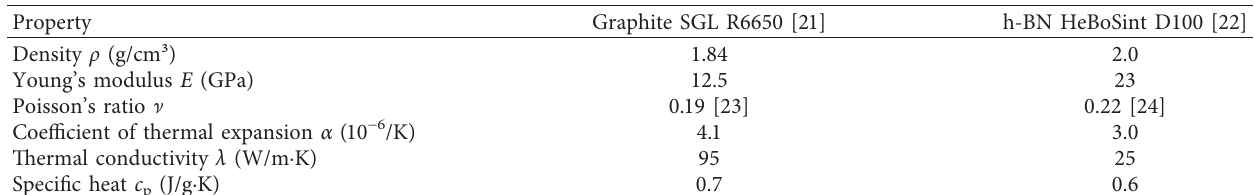
Table 1: Properties of isotropic graphite grade SIGRAFINE R6650 produced by SGL Group and h-BN grade HeBoSint D100 produced by Henze Boron Nitride Products, used in this work.